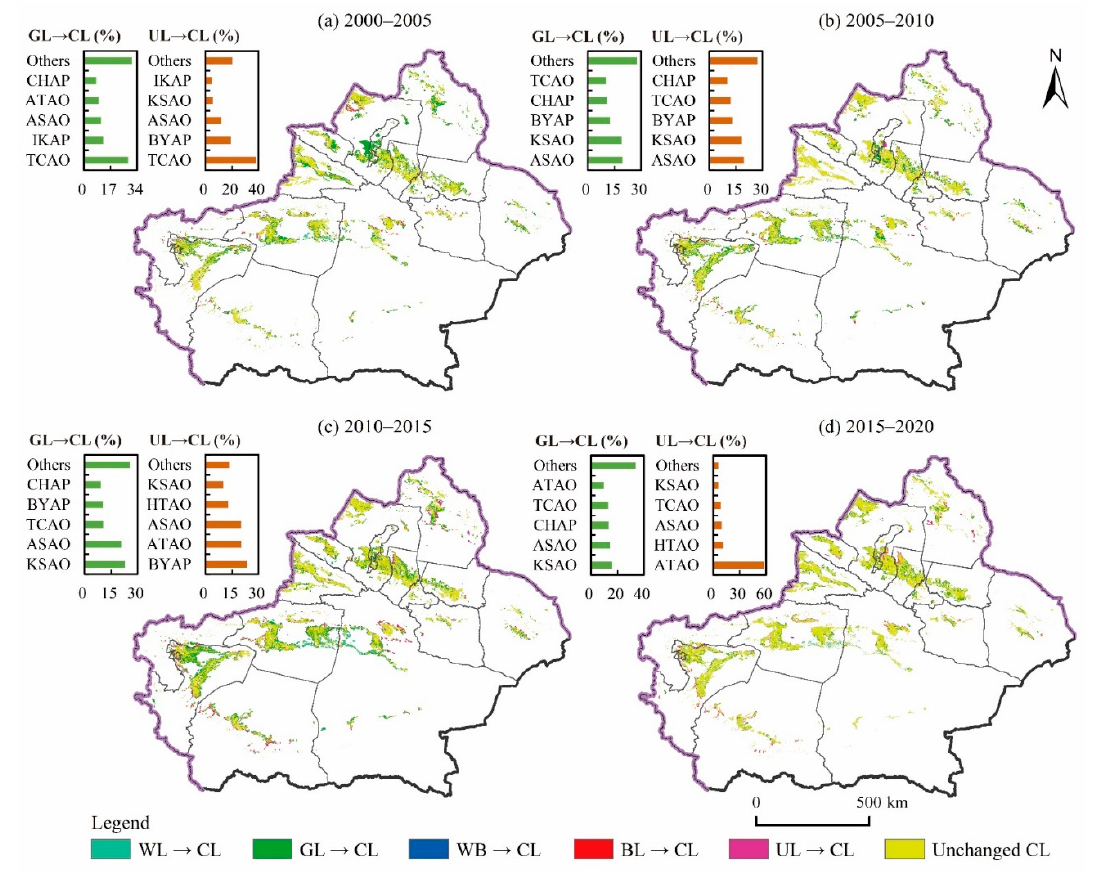
Figure 4. Spatial distribution of newly added cropland in Xinjiang: ( a ) during 2000–2005; ( b ) during